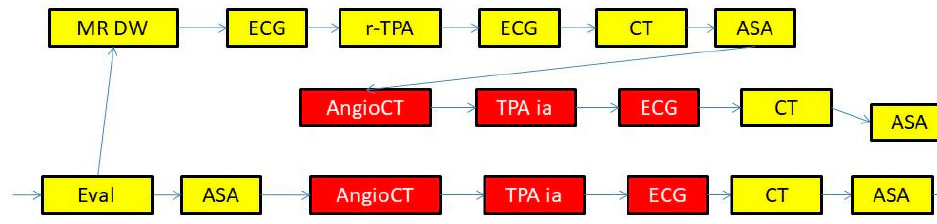
Figure 2. The results of the example search.